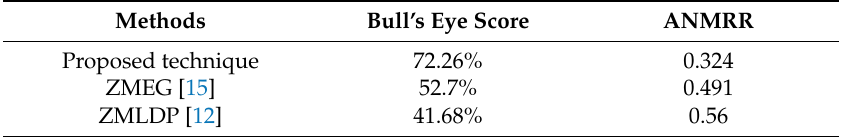
Table 1. Averages of the Bull’s eye and average normalized modified retrieval rank (ANMRR) scores.